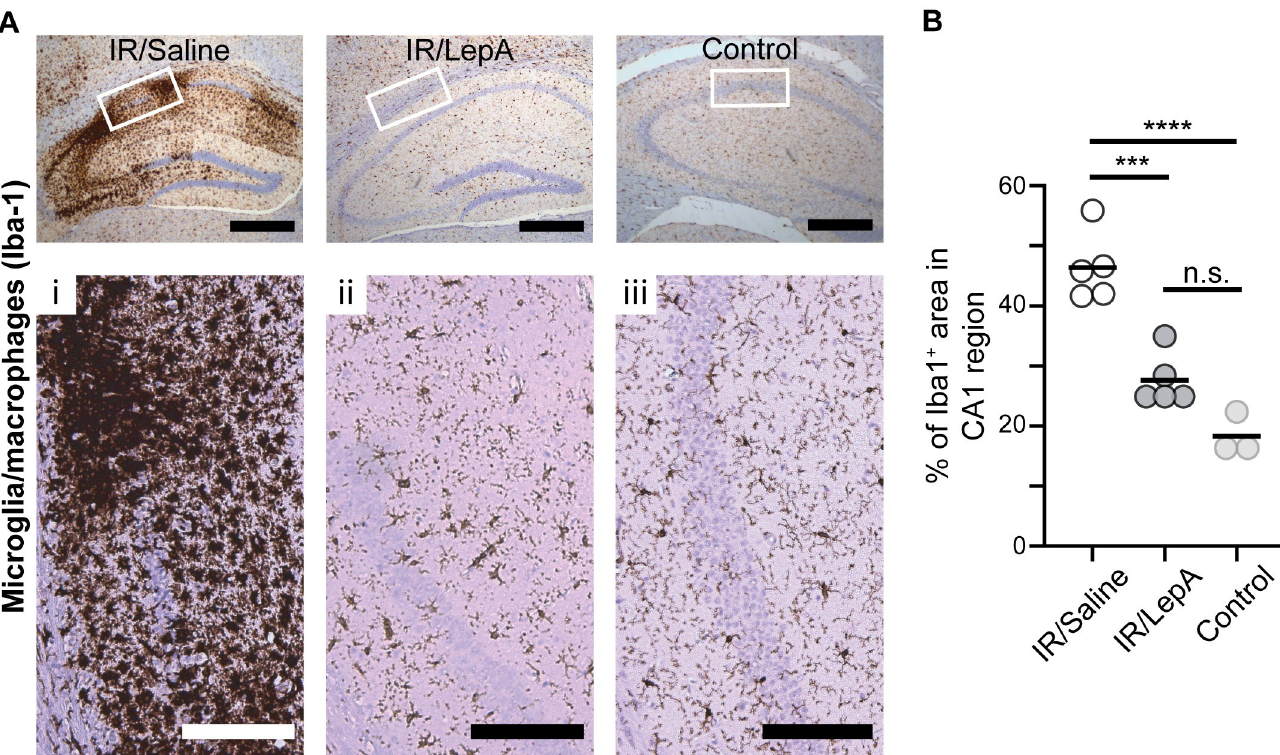
Fig 3. Intraarterial LepA injection via ipsilateral ICA following ischemia and reperfusion injury reduces neuroinflammation in the CA1 region. ( A ) Activated microglia are abundant in the CA1 region of IR/saline-injected samples (i), fewer in IR/LepA-injected samples (ii), and mildly less in control (untreated mice; iii). Scale bars are 500 μ m and 200 μ m for low and high magnification, respectively. ( B ) IR resulted in changes in Iba-1 density (n = 8 for saline and control groups and n = 13 for LepA group, Kruskal-Wallis H = 22.89, p < 0 . 0001 ), with increased density of Iba1-positive cells in the CA1 region of IR-saline mice compared to IR-LepA ( p = 0 . 0127 ) and control, untreated, mice ( p < 0 . 0001 ). A small increase in Iba-1 was evident following IR with LepA treatment compared to control ( p = 0 . 0420 ).